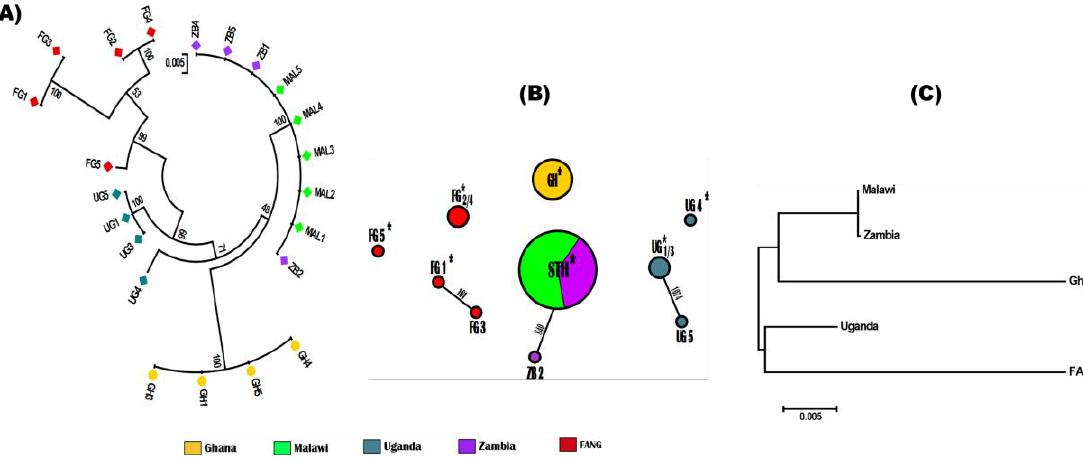
Figure 4. Pattern of genetic variability and polymorphism of CYP6AA1 DNA sequences across Africa. ( A ) Maximum likelihood phylogenetic tree of CYP6AA1 DNA sequences; ( B ) Haplotype networks (TCS) for the CYP6AA1 sequences in A. funestus . STH = haplotype shared between Malawi and Zambia; GH = Ghana; UG = Uganda; ZB = Zambia; FG = FANG. Haplotypes are presented in circular shape scaled to reflect their respective frequencies. * = ancestral haplotype. Lines connecting haplotypes represent a single mutation event (respective polymorphic positions are given on each branch). ( C ) Neighbor-joining tree of the genetic distances showing that southern (Malawi and Zambia), West (Ghana) and East (Uganda and FANG) populations are genetically differentiated.